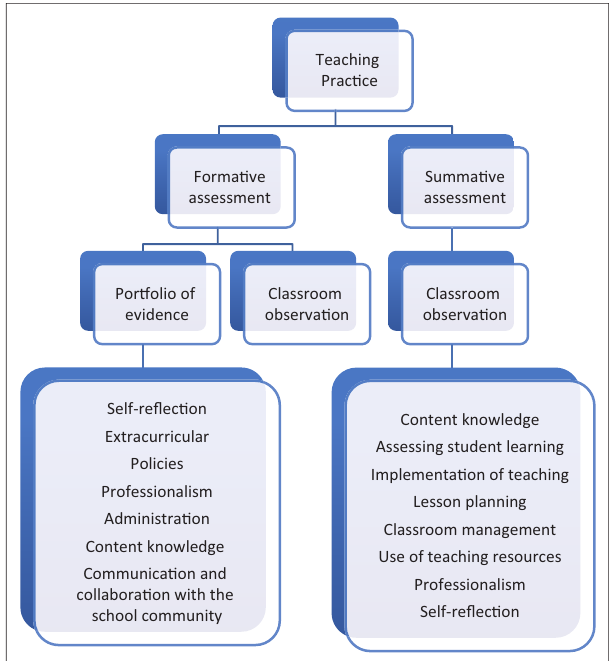
FIGURE 1: A suggested model for a holistic assessment of teaching